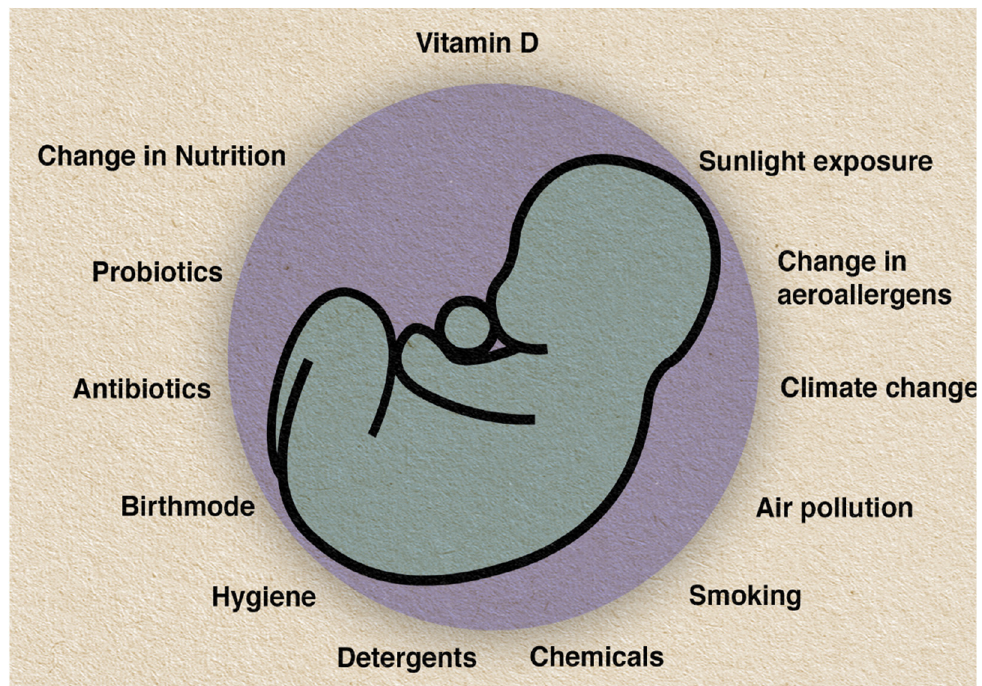
Figure 1. A number of potentially causative pre- and early postnatal environmental factors may influence the development of allergic diseases. The hygiene hypothesis suggests that increased hygiene with a lack of exposure to microbes and parasitic infections at an early age prevents the developing immune system from forming tolerance. In modern societies, increased time is spent indoors, which can lead to reduced sunlight exposure and vitamin D production. Additionally, change in nutrition and use of pro- and antibiotics, detergents and chemicals need to be considered in the context of allergy development. Furthermore, mode of delivery, smoking, air pollution, climate change and change in aeroallergens may contribute to the development of allergic diseases in early childhood.